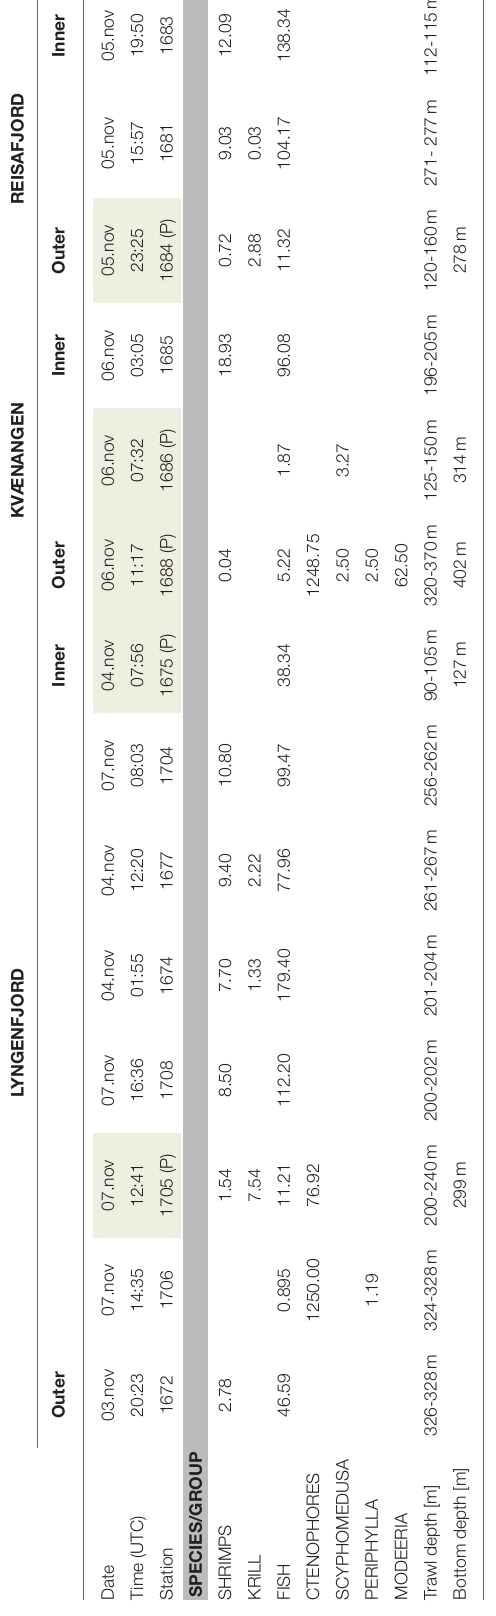
the maps were produced using Matlab R2013a and M_Map version